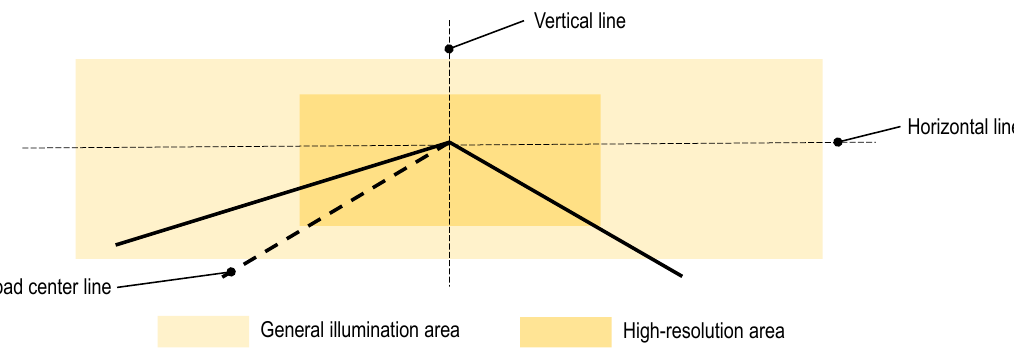
Figure 1. Example of the illumination distribution of a high-resolution headlamp, which includes a general illumination area and a high-resolution